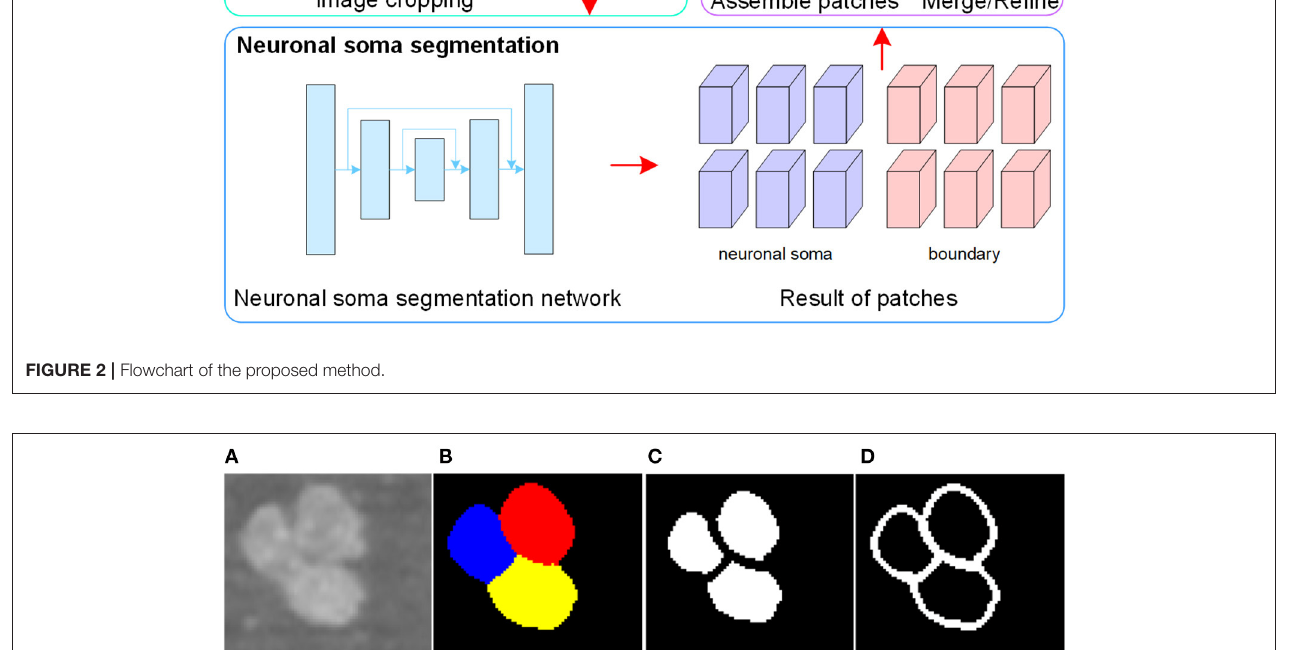
FIGURE 3 | Sample labels. (A) Raw image slice. (B) Manually labeled neuronal somata, individual soma is labeled by unique random color. (C) Unconnected neuronal somata label. (D) Boundary label. The neuronal soma region and boundary region have a complementary spatial